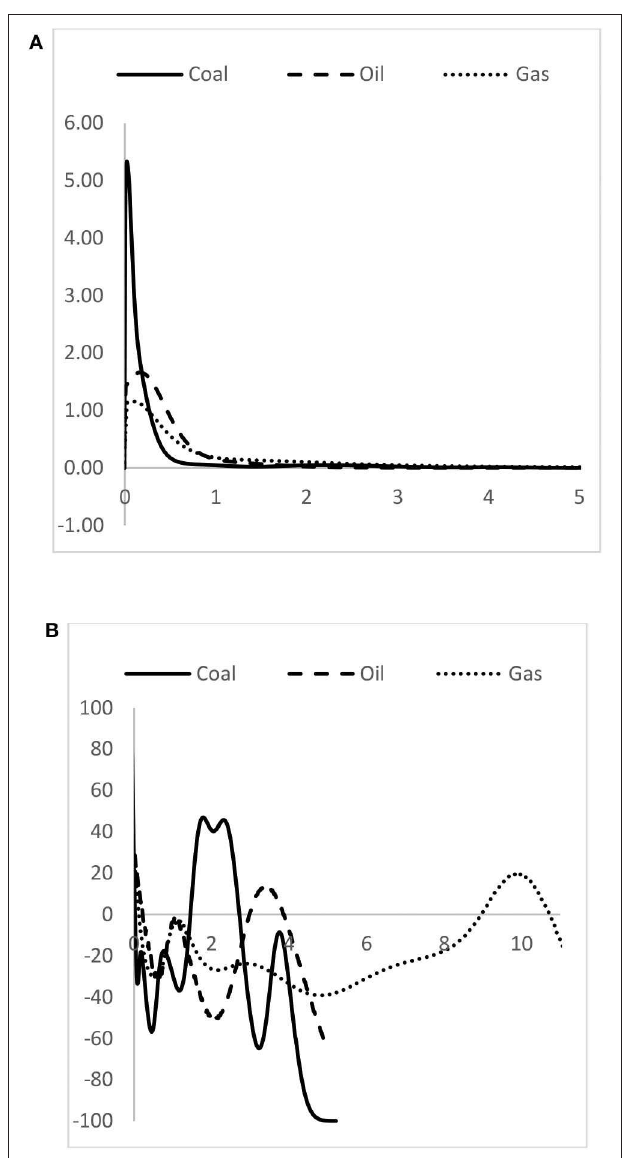
FIGURE 10 | Comparison of the ergodic distributions and MPPs of the coal, oil, and gas markets for the lower-middle-income countries. Note: For (A) , horizontal axis represents relative per capita consumption, vertical axis represents proportion. For (B) , horizontal axis represents relative per capita consumption, vertical axis represents MPP. Source: Authors’